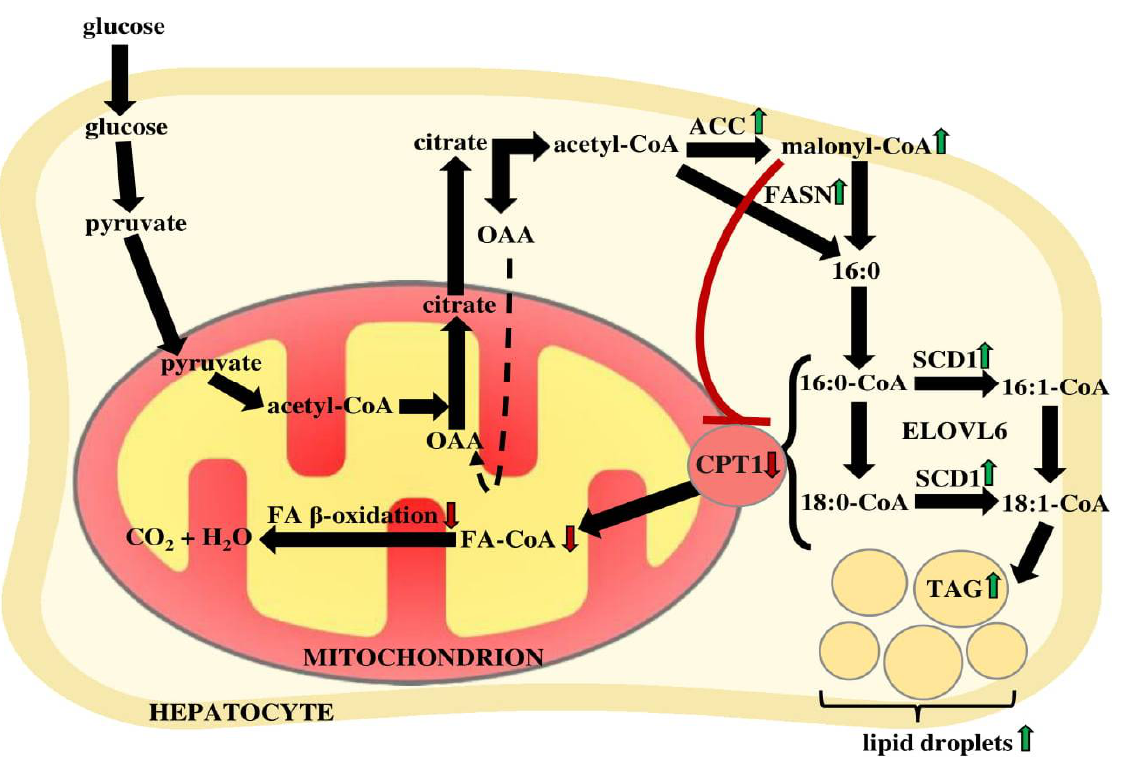
Figure 2. Lipid alterations in hepatocytes of patients with NAFLD. Lipid accumulation is a result of: (1) increased expression of the enzymes of lipid synthesis (acetyl-CoA carboxylase—ACC and fatty acid synthase—FASN) and desaturation (stearoyl-CoA desaturase—SCD1); (2) inhibition of carnitine palmitoyltransferase 1 (CPT1), which limits the transport of FA from the cytosol to the mitochondria, when they undergo beta-oxidation by excessive level of malonyl-CoA. FA—fatty acid, OAA—oxaloacetate, TAG—triacylglycerol.